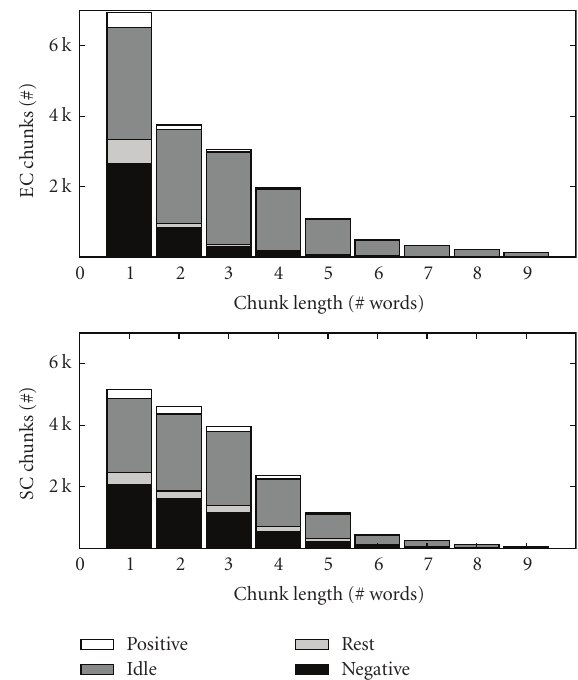
Figure 2: Chunk histogram with frequencies,